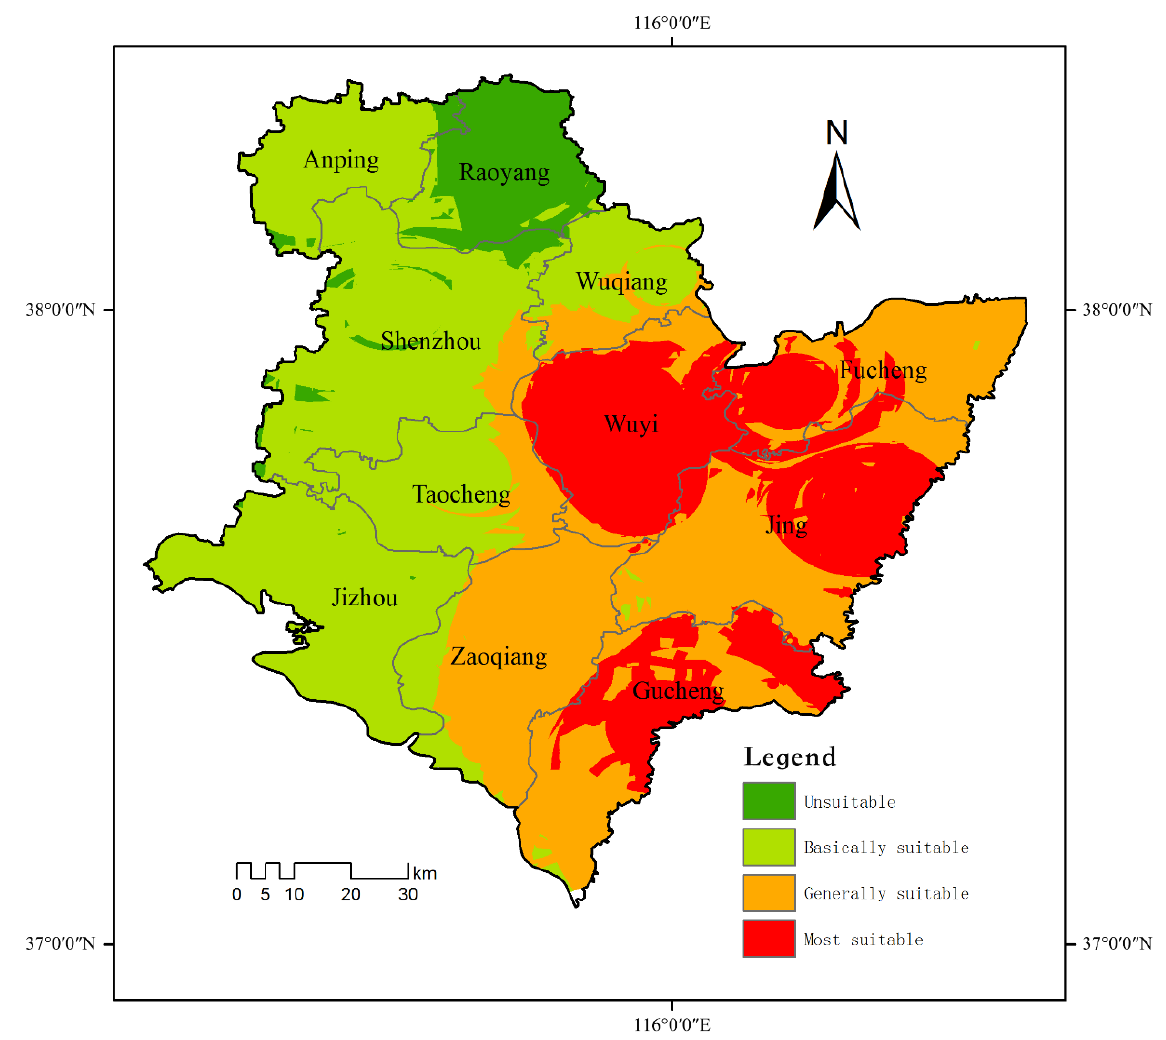
Figure 5. Suitability classification diagram.